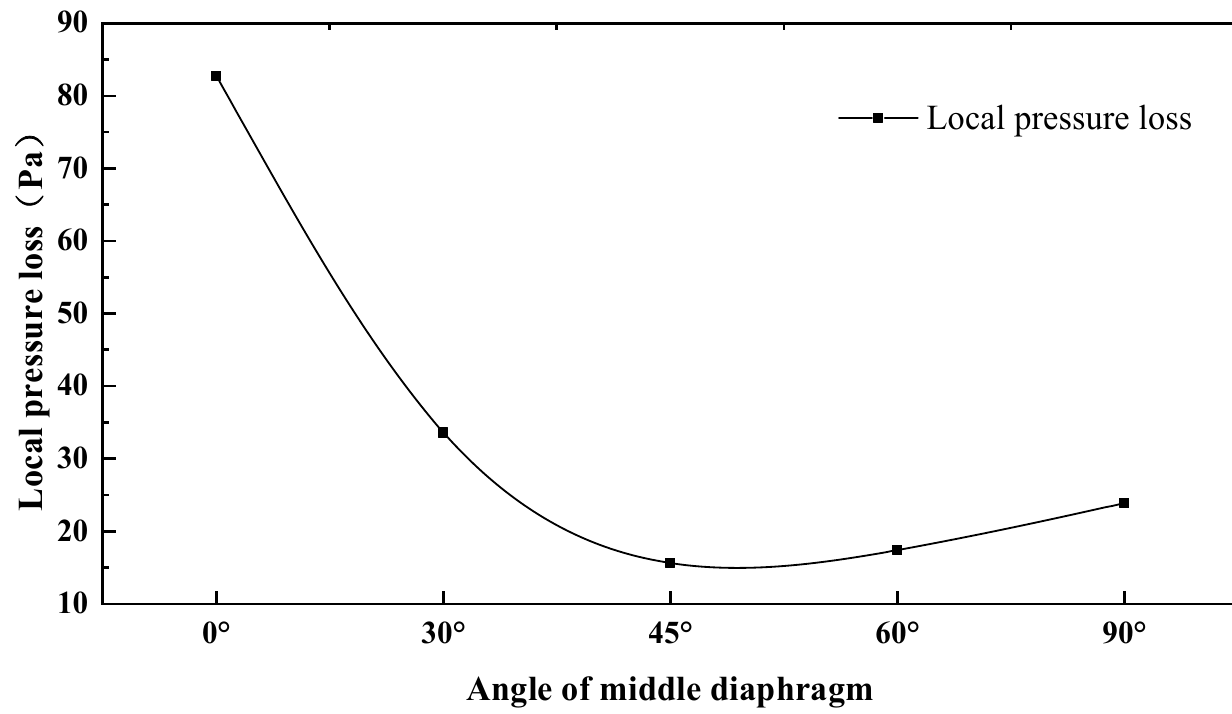
Figure 16. Local resistance in different angles of the middle diaphragm.